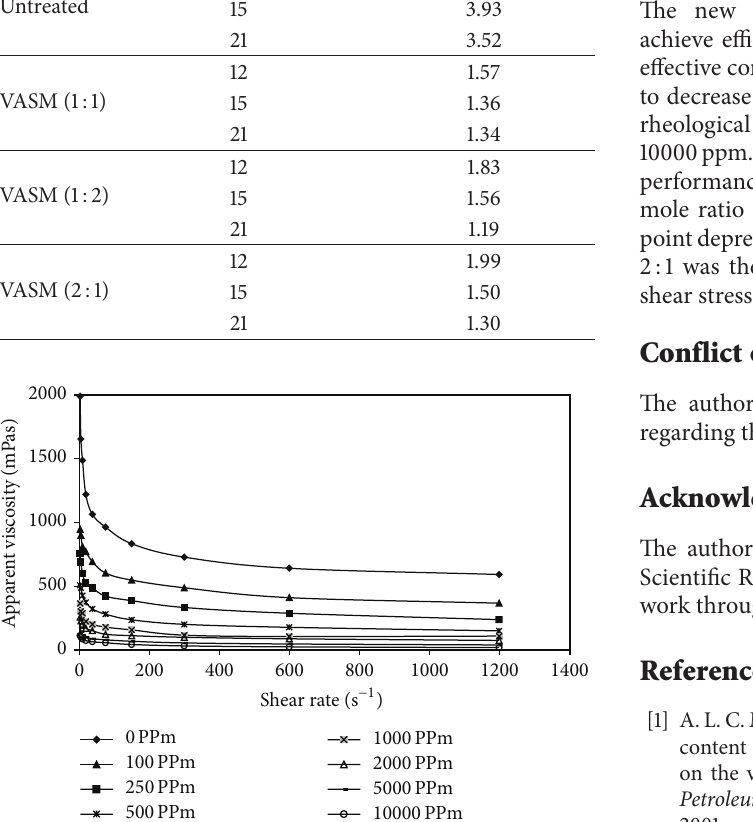
Figure 9: Effect of VASM (2 :1) on the apparent viscosity on Norpetco crude oil at 15 ∘